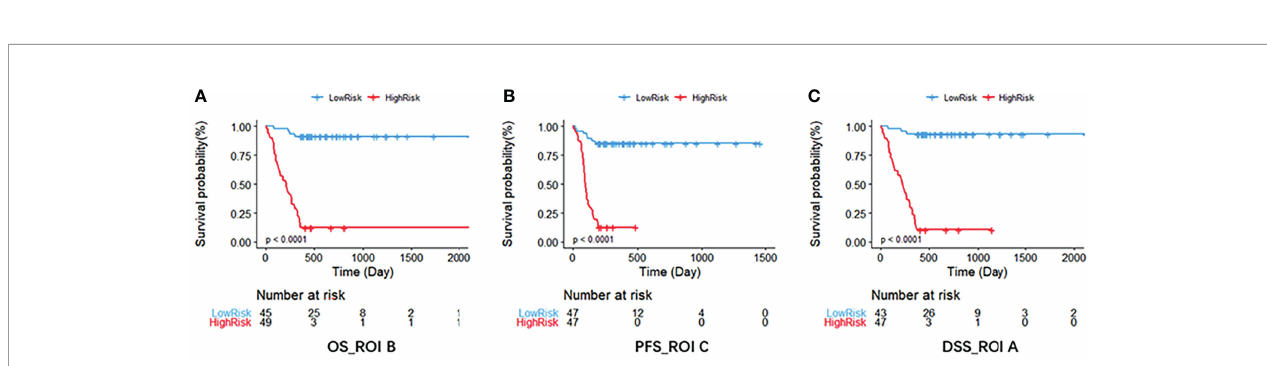
FIGURE 6 | The calibration curves of the radiomics nomogram in the training cohort (A, C, E) and validation cohort (B, D, F) of the three survival groups. The calibration curves depict the calibration of the nomogram in terms of the agreement between the predicted risk and the observed risk of survival. DSS, disease- speci fi c survival; OS, overall survival; PFS, progression-free survival; ROI, region of interest.